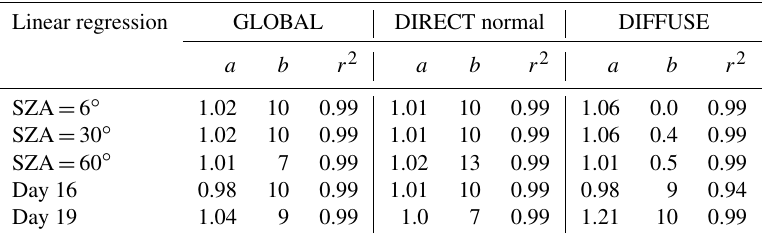
Table 1. Linear regression parameters ( a is the slope, b the intercept, and r 2 the coefficient of determination) applied to the irradiance values of the comparison between SSolar-GOA and libRadtran models for the three solar components and the three SZAs. The same for the day 16 and 19 of Figs. 8 and 9 of the comparison between measured LI-1800 and modelled SSolar-GOA irradiance spectra. Linear regression